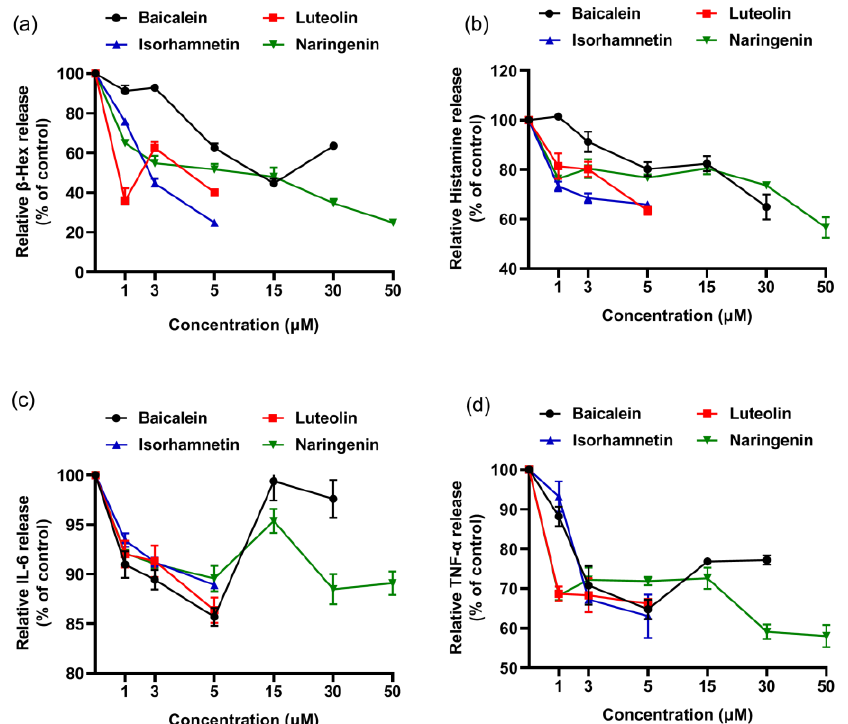
Figure 7. Dose-effect relationship of four flavonoids inhibiting mediator release from KU812 cells induced by ω -5 gliadin-derived peptide P4. ( a ) Dose-effect relationship of flavonoids for inhibition β -Hex release; ( b ) dose-effect relationship of flavonoids for inhibition histamine release; ( c ) dose-effect relationship of flavonoids for inhibition IL-6 release; ( d ) dose-effect relationship of flavonoids for inhibition TNF- α release.